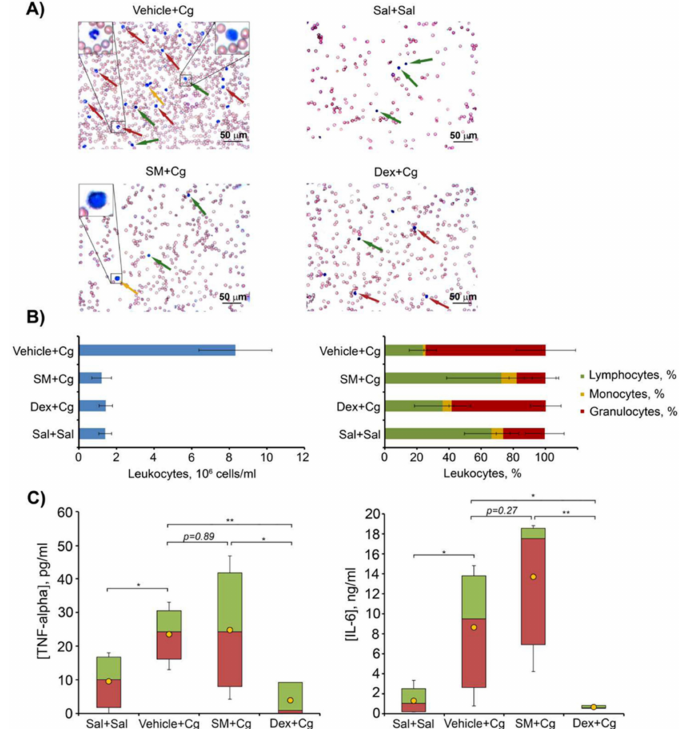
Figure 9. Anti-inflammatory effect of SM on the carrageenan-induced peritonitis model. ICR mice were intraperitoneally (i.p.) administered with SM in 10% Tween-80 (vehicle) at a dose of 50 mg / kg 1 h prior to peritonitis induction by 1% carrageenan followed by the counting of leukocytes in peritoneal fluid 4 h after carrageenan injection. Dexamethasone (0.5 mg / kg) was used as a reference drug. ( A ) The distribution of leukocyte subpopulations was evaluated by light microscopy after azur-eosin staining by the Romanovsky–Giemsa method. Red arrows show neutrophils, green arrows show lymphocytes, and yellow arrows show monocytes. Magnification × 400. ( B ) Total (left panel) and differential (right panel) leukocyte counts in peritoneal exudates. ( C ) Pro-inflammatory cytokines TNF- α and IL-6 were measured by ELISA 4 h after peritonitis induction. Differences between groups were statistically significant at * p < 0.05 and ** p <